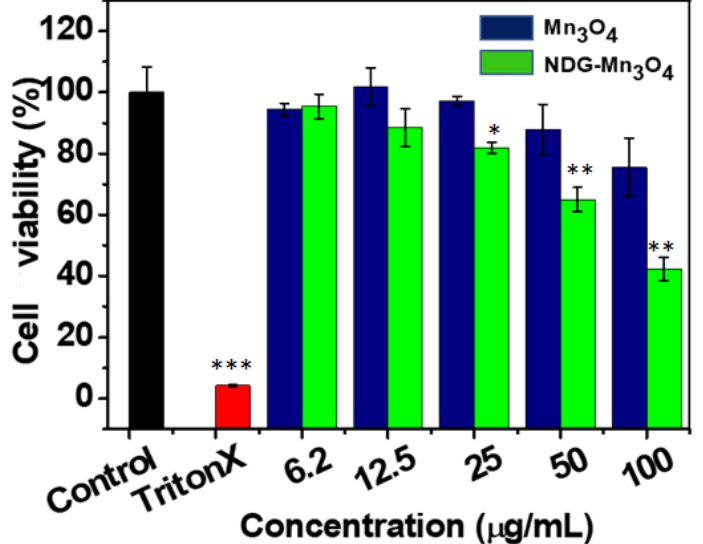
Figure 5. Cell viability of A549 cells incubated with PBS (control), Triton X-100 (negative control) and different concentrations of, Mn 3 O 4 and NDG-Mn 3 O 4 nanocomposites in presence of 670 nm laser irradiation (0.1 W/cm 2 ) for 5 min. Data is represented as mean values of three replicates (±) standard deviations. * p < 0.05, ** p < 0.01 and *** p < 0.001 versus respective control groups.